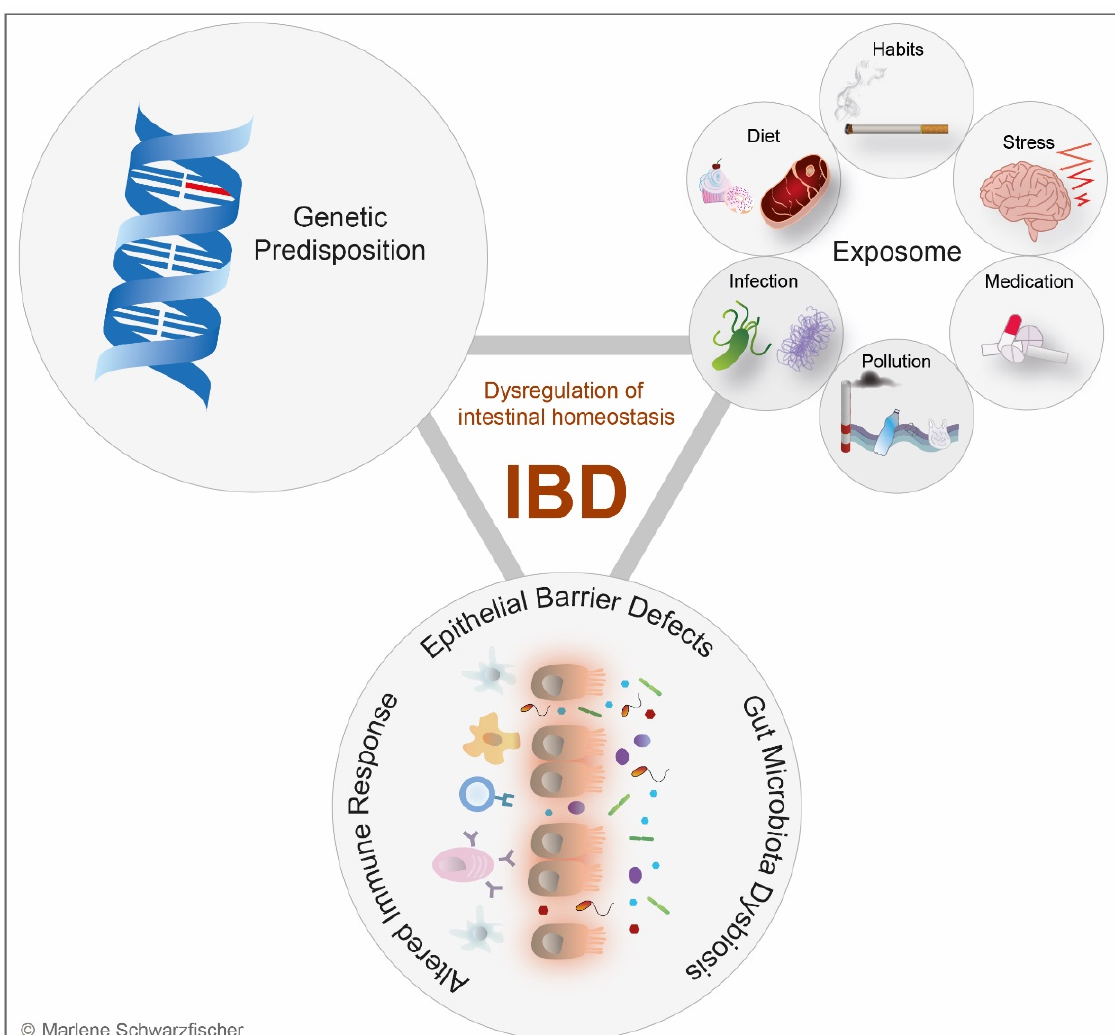
Figure 1. IBD—a multifactorial disease. IBD pathogenesis is driven by an interplay of genetic and environmental risk factors, causing epithelial barrier defects, microbial dysbiosis, and excessive up- or downregulation of the immune response, which culminates in dysregulation of the intestinal homeostasis and intestinal inflammation. Environmental factors can influence the onset and course of IBD and are collectively referred to as the exposome. For example, cigarette smoking, stress, medication, air and water pollution, infections, and dietary preferences were shown to modulate IBD risk.